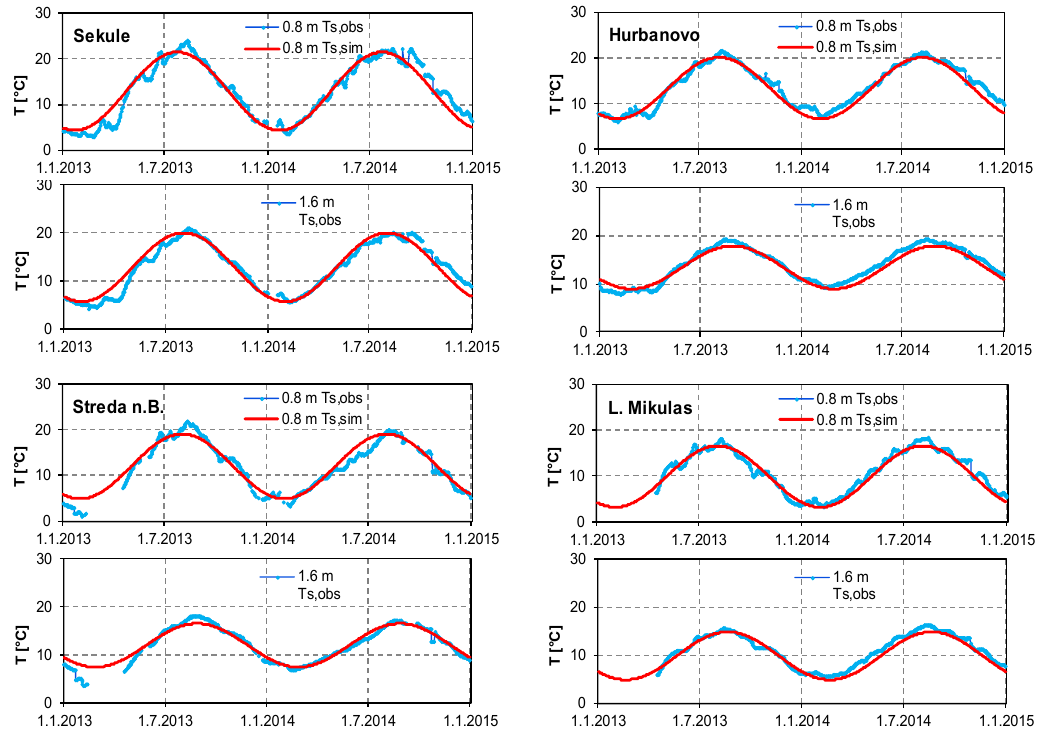
Figure 6. Daily modelled ( Ts,sim ) and measured ( Ts,obs ) soil temperatures at depths of 0.8 and 1.6 m over the period 2013–2014 (the calibration period). Stations: 1. Sekule, 2. Hurbanovo, 3. Streda n. Bodrogom, and 4. Liptovský Mikuláš.